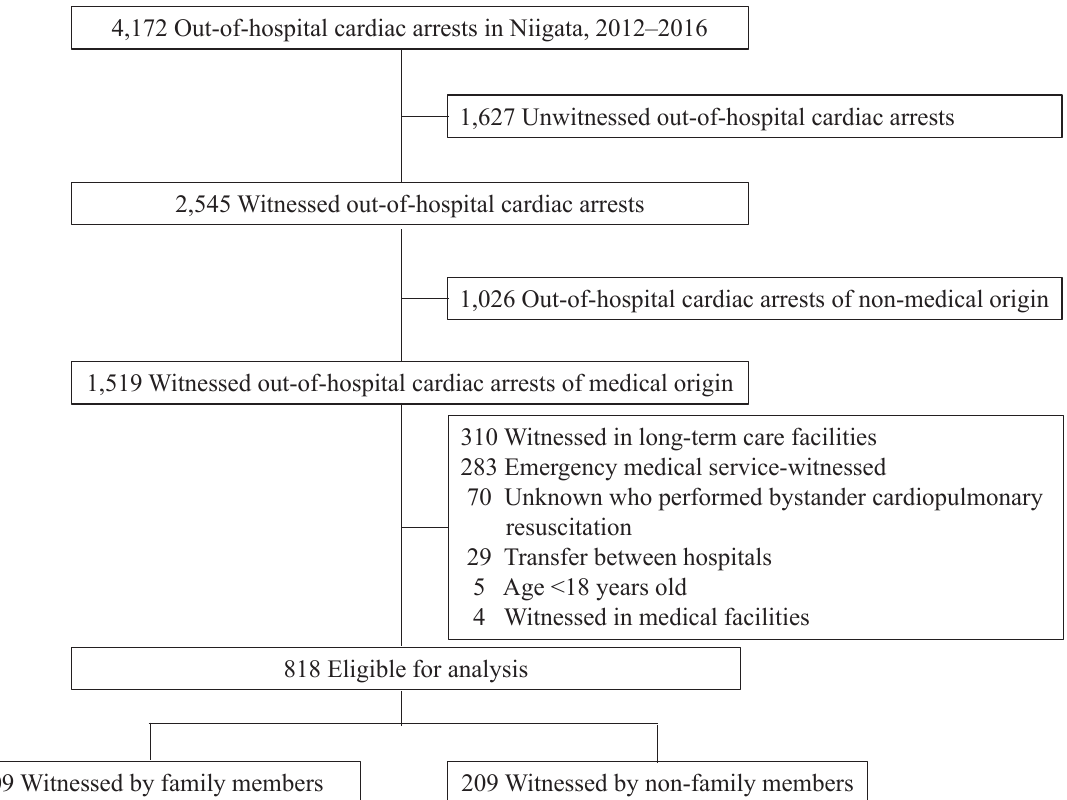
Figure 1. Patients with out-of-hospital cardiac arrests during the study period and patients included in the analysis